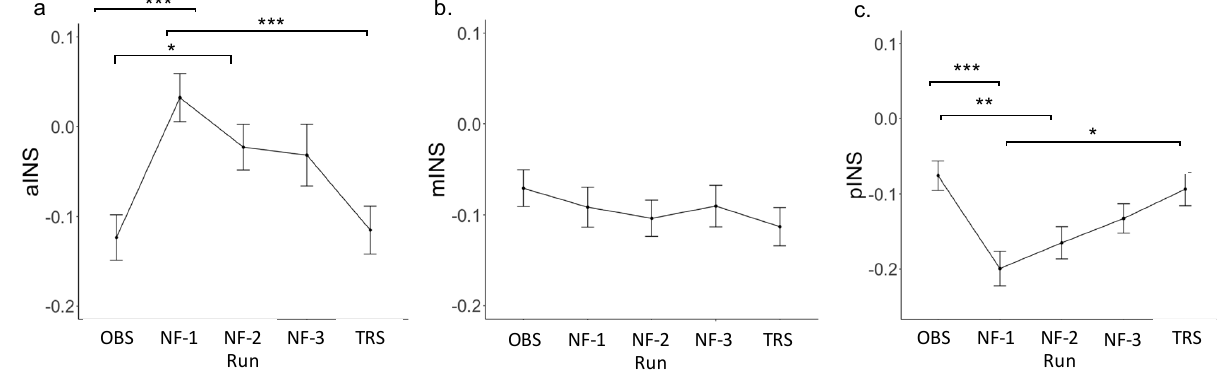
Figure A2. ( a – c ), parameter estimate (Focus-on-Breath vs. Rest) across runs for insula subregions. Abbreviations: OBS, Observe; NF, neurofeedback run; TRS, Transfer * p < 0.05. ** p < 0.01. *** p < 0.001.